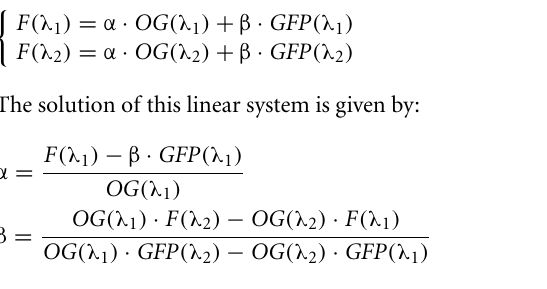
FIGURE 2 |Two-photon excitation spectra of EGFP and OG in cultured cells. (A) Upper panels: the excitation spectra of EGFP is visualized in HeLa cells excited at various wavelengths.The excitation power was regulated in order to maintain a constant photon flux at the objective output at all wavelengths. Calibration bar 30 µ m. Lower panels: cells transfected with EGFP have been also loaded with OG and the images show the resulting